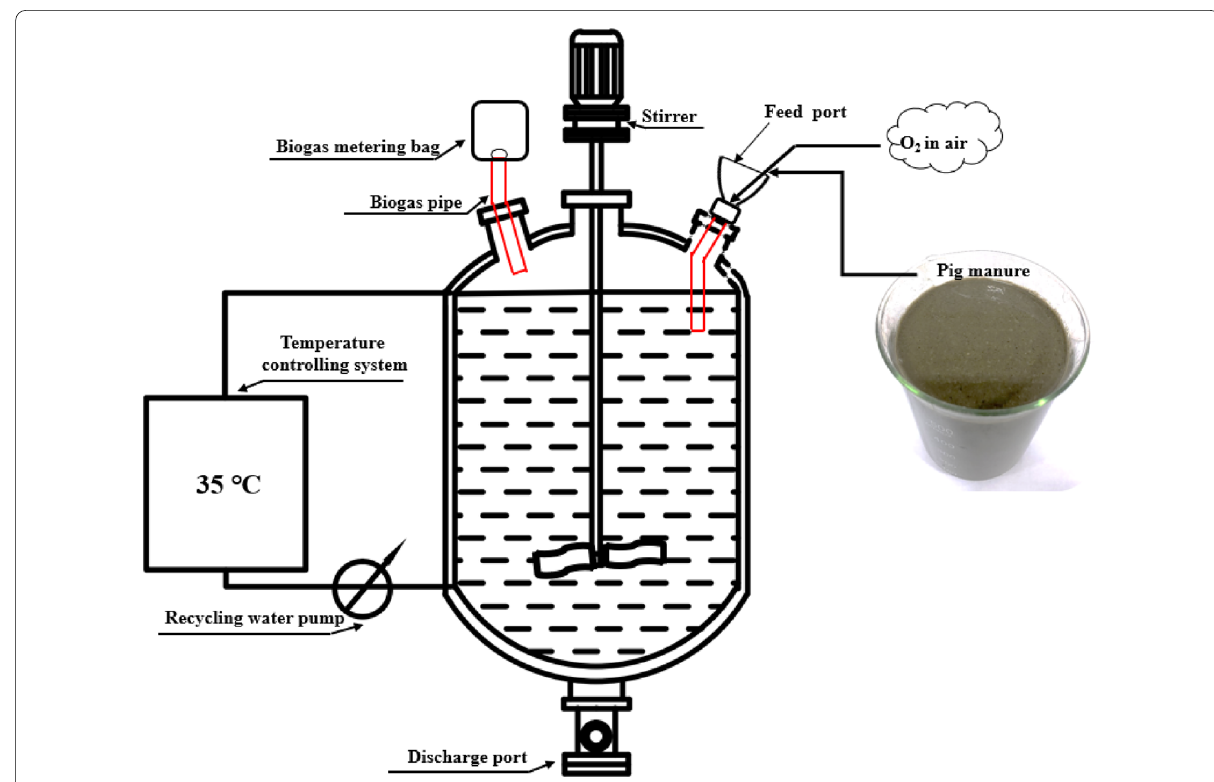
Fig. 1 Schematic diagram of the CSTR system used in the present